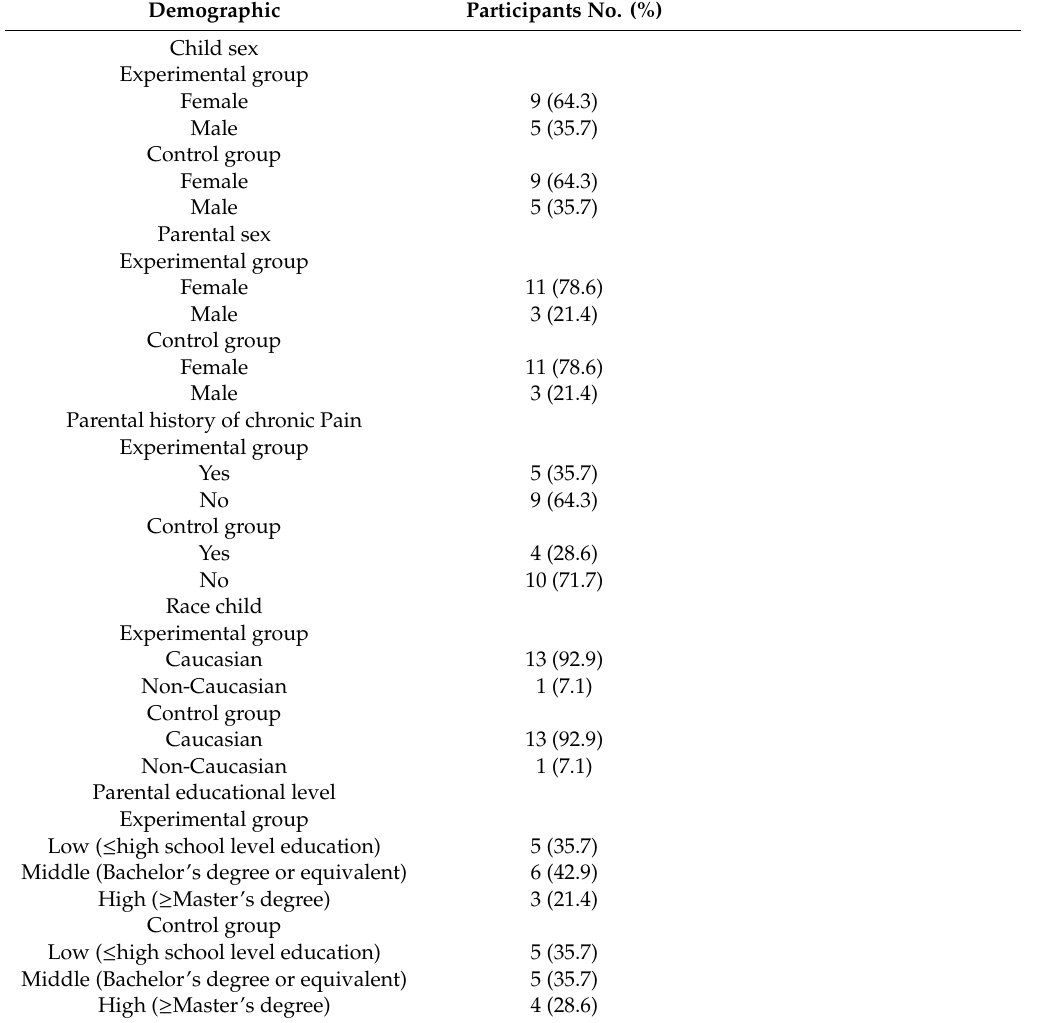
Table 1. Demographic and Baseline Characteristics of the